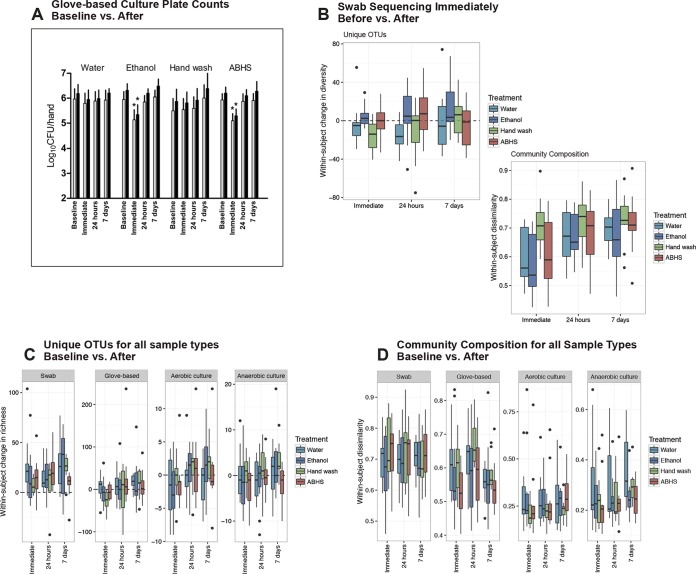
Impact of methodology on observed hygiene effects. (A) Quantity of viable aerobic (light bars) and anaerobic (dark bars) bacteria recovered per hand at baseline by glove-based sampling immediately after, 24 h after, and 7 days after use of an ABHS, hand wash, ethanol control, or water control. Asterisks indicate significant differences observed compared with baseline (P < 0.05, ANOVA). Bars indicate means and error bars the 95% confidence intervals. (B) The OTU richness and Bray-Curtis dissimilarity within-subject diversity in community composition between samples collected immediately before and samples collected immediately, 24 h, and 7 days after use of an ABHS, hand wash, ethanol control, or water control as assessed with swab samples. (C and D) Within-subject OTU counts (C) and dissimilarity in community composition (D) observed from swabs, glove-based samples, and anaerobic and aerobic culture plating of glove-based changes between samples collected at baseline and samples collected immediately, 24 h, and 7 days after use of an ABHS, hand wash, ethanol control, or water control. n values for test groups are as follows: water = 14, ethanol = 13, hand wash = 11, and ABHS = 12.